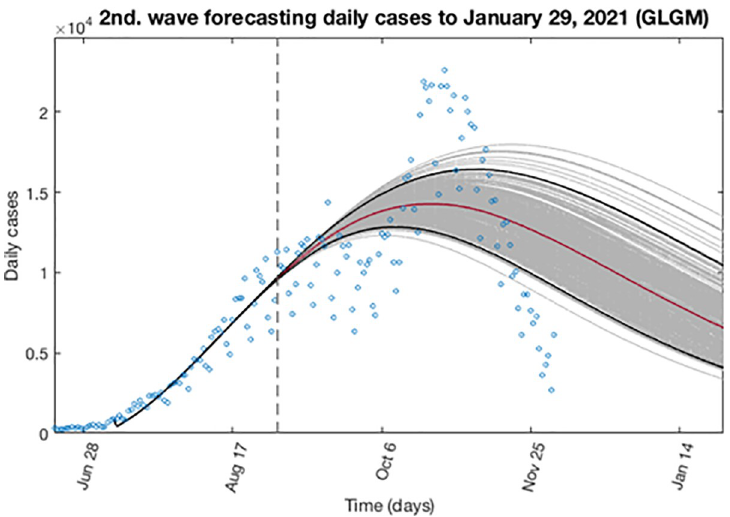
Fig 14. Characterization of the expected daily epidemic profile for the second wave using GLGM. The blue circles are the cases reported daily; red line corresponds to the best fit of the GLGM to the data. Grey lines correspond to the m bootstrapping realizations of the epidemic curves. Black lines correspond to the 95% CI bounds.